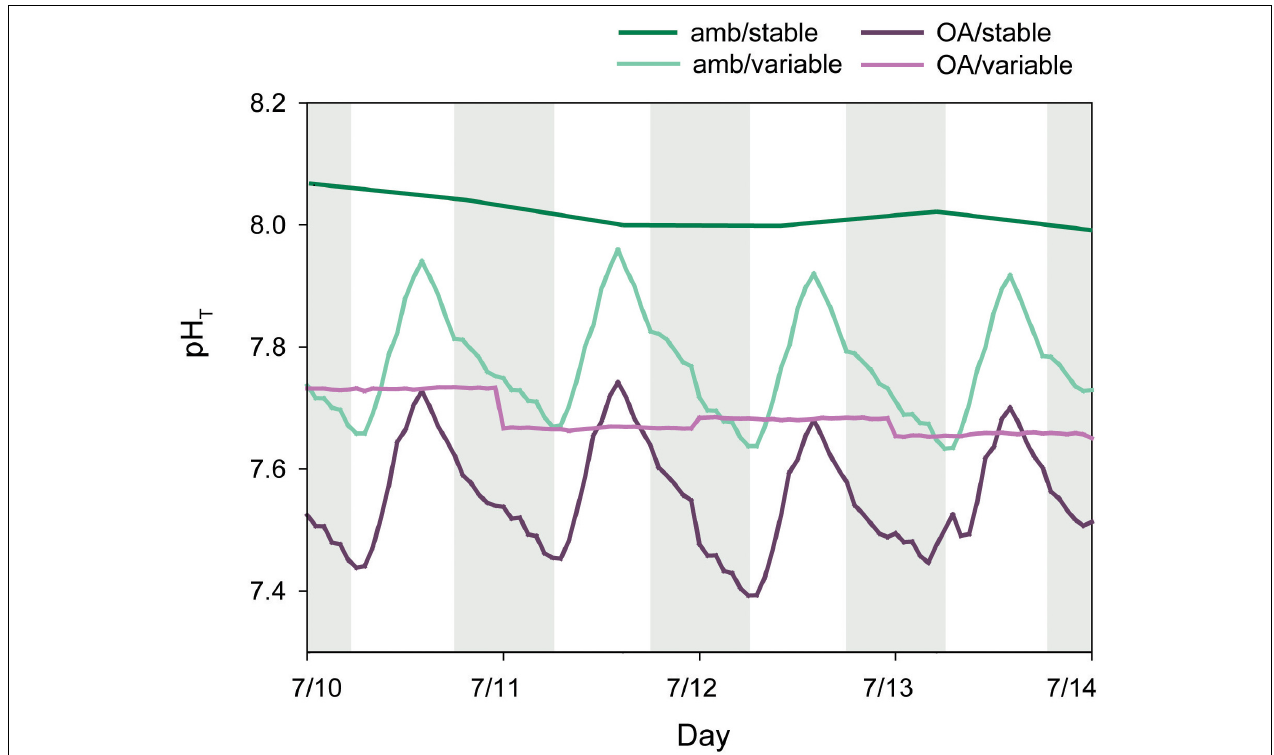
FIGURE 2 | Mean hourly pH T (total scale) from treatment reservoir tanks and daily pH T from discrete measurements of ambient tanks. Shaded areas indicate